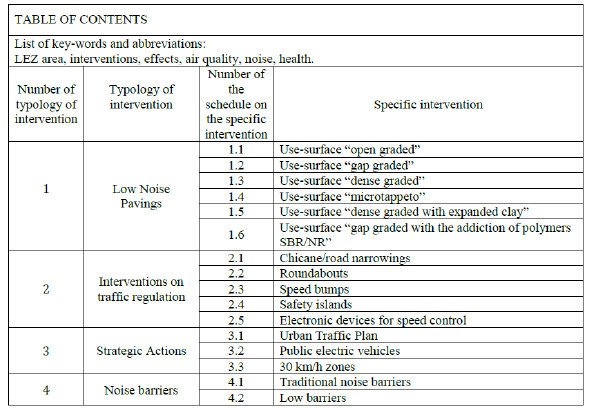
Figure 5: List of analysed typologies of